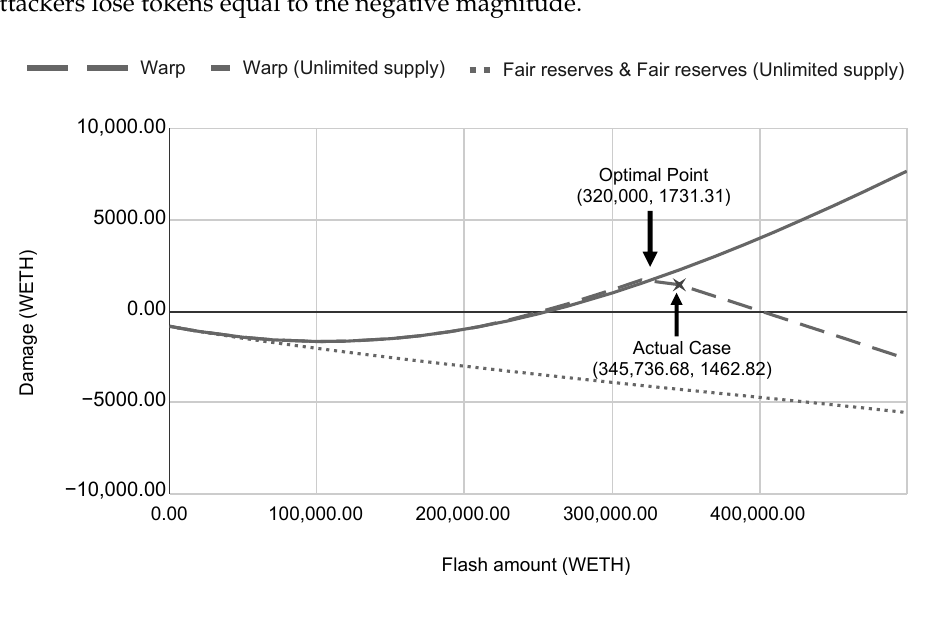
Figure 3. Dynamic flash loan size